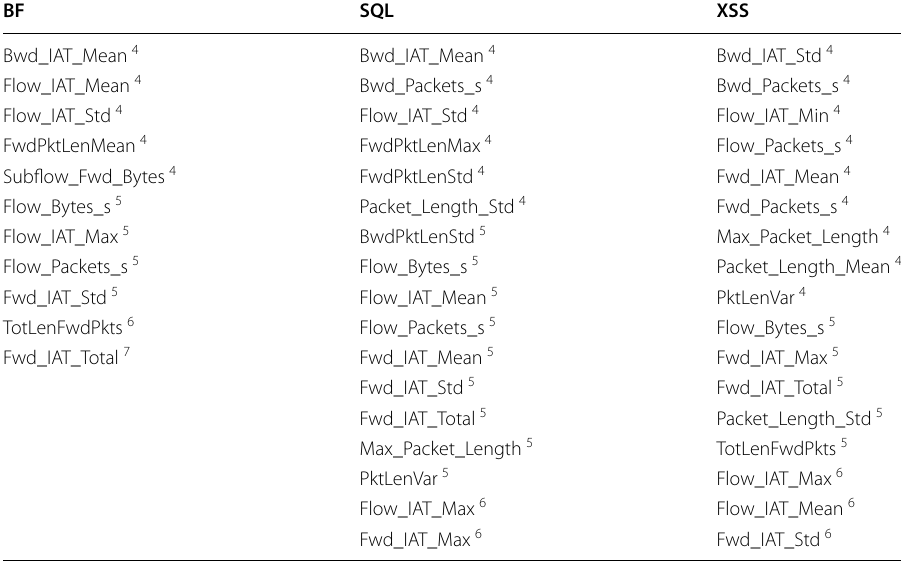
(numeric superscripts indicate fst A , the number of FSTs agreeing on that feature for that attack)